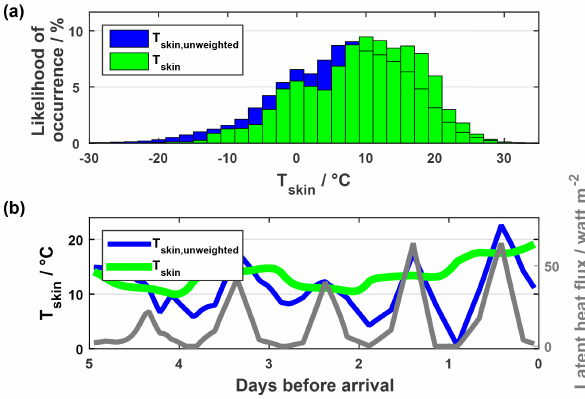
Figure 2. (a) Probability distributions of continental GDAS skin temperatures ( T skin,unweighted ) (blue) and of skin temperatures weighted with the accumulated hourly latent heat flux at ground level within ± 12h ( T skin ) (green). The occurrence of low tempera- tures is reduced as a consequence of the weighting. A peak around 0 ◦ C becomes more clearly visible. (b) Illustration of the weighting algorithm for one exemplary back trajectory (arrival in Karlsruhe 4 May 2012,